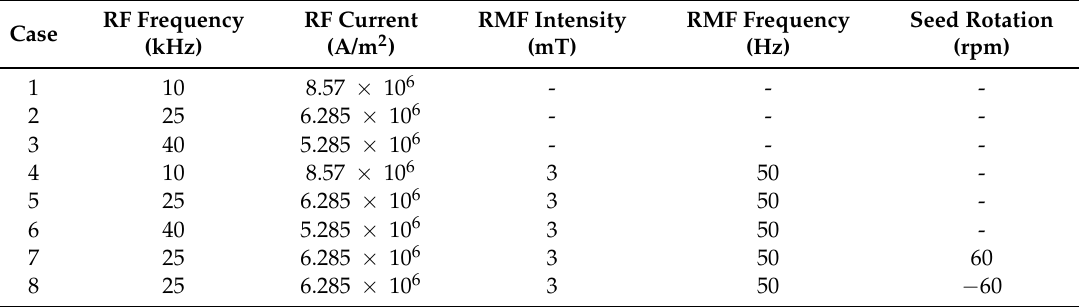
Table 2. Input parameters used for induction